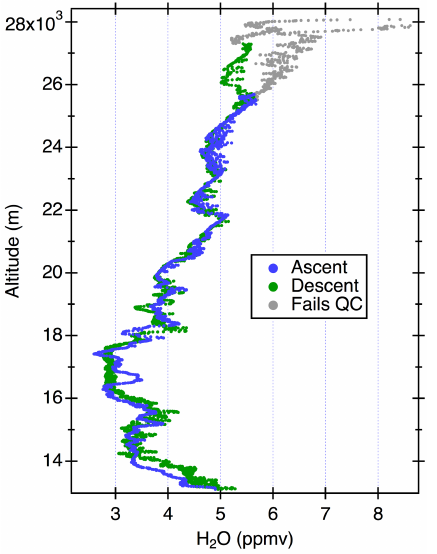
Figure 3. Stratospheric water vapor mixing ratio profiles measured by the NOAA FPH during balloon ascent (blue) and controlled de- scent (green) over Boulder, Colorado. The two profiles are simi- lar except above 25.5km where the ascent measurements become contaminated by the persistent outgassing of moisture from the bal- loon and flight train. High-quality, uncontaminated FPH measure- ments (those passing quality control) resume during controlled de- scent at ∼ 27km, approximately 1km below the altitude of balloon turnaround (float).